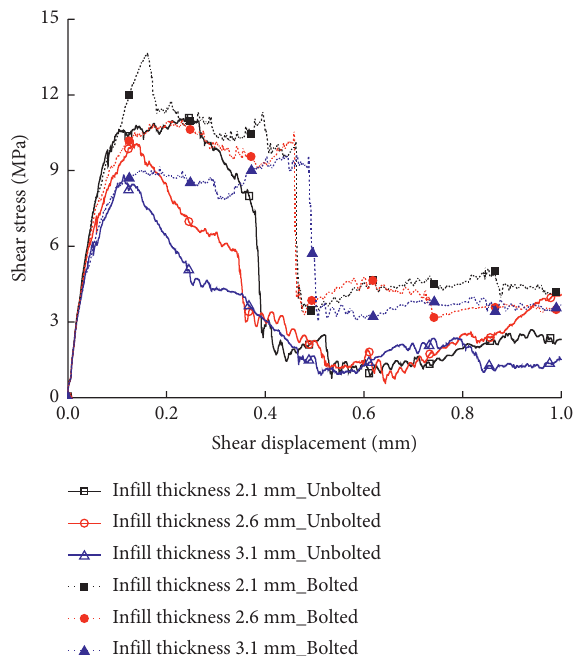
Figure 18: Relationship between shear stress and shear displacement under different infill thicknesses.